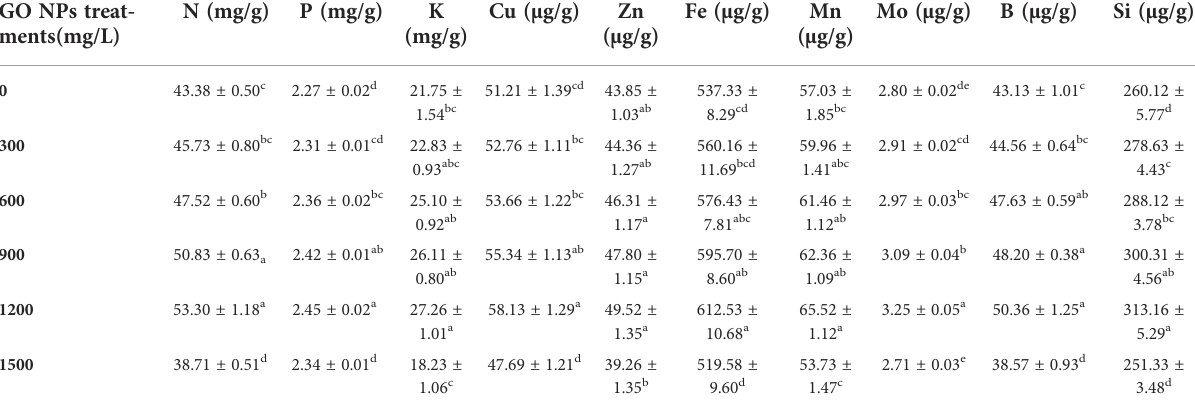
TABLE 3 Effects of different GO NPs treatments on nutrient uptake of mungbean. GO NPs treat-